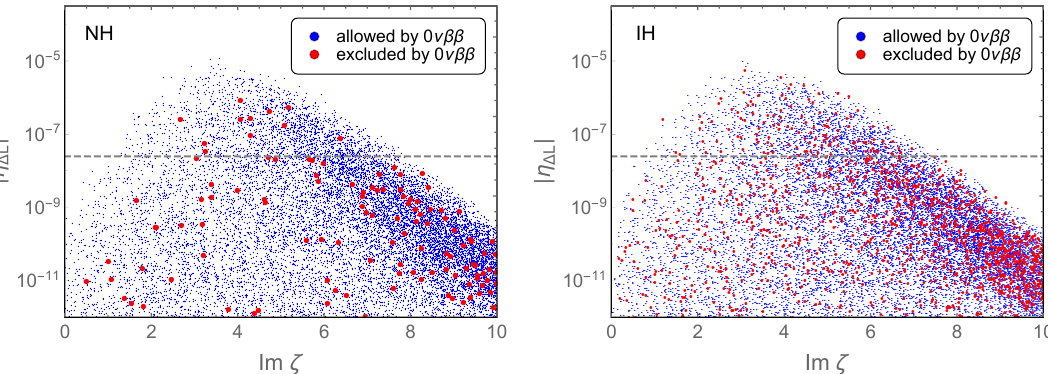
(cid:17) (cid:1) L on the parameter (cid:16) , for the j j